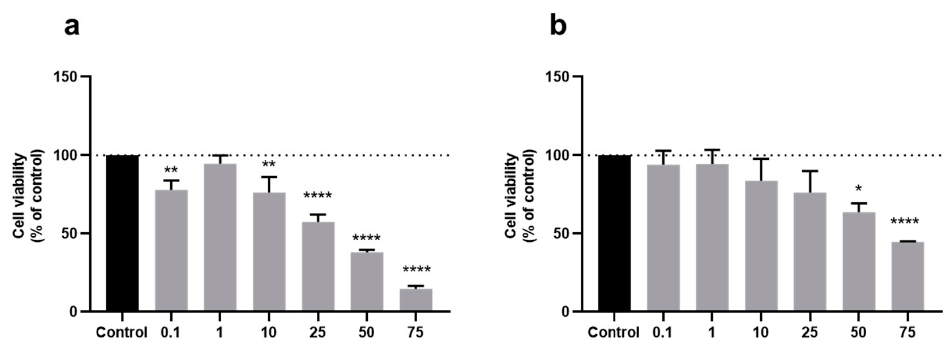
Figure 8. Relative viabilities of ( a ) MCF-7 and ( b ) PC-3 cells after 72 h incubation with several concentrations of Br-Cla, always without light irradiation. Results are presented as mean ± SEM. * Statistically significant vs. control at p < 0.05; ** statistically significant vs. control at p < 0.01; **** statistically significant vs. control at p <